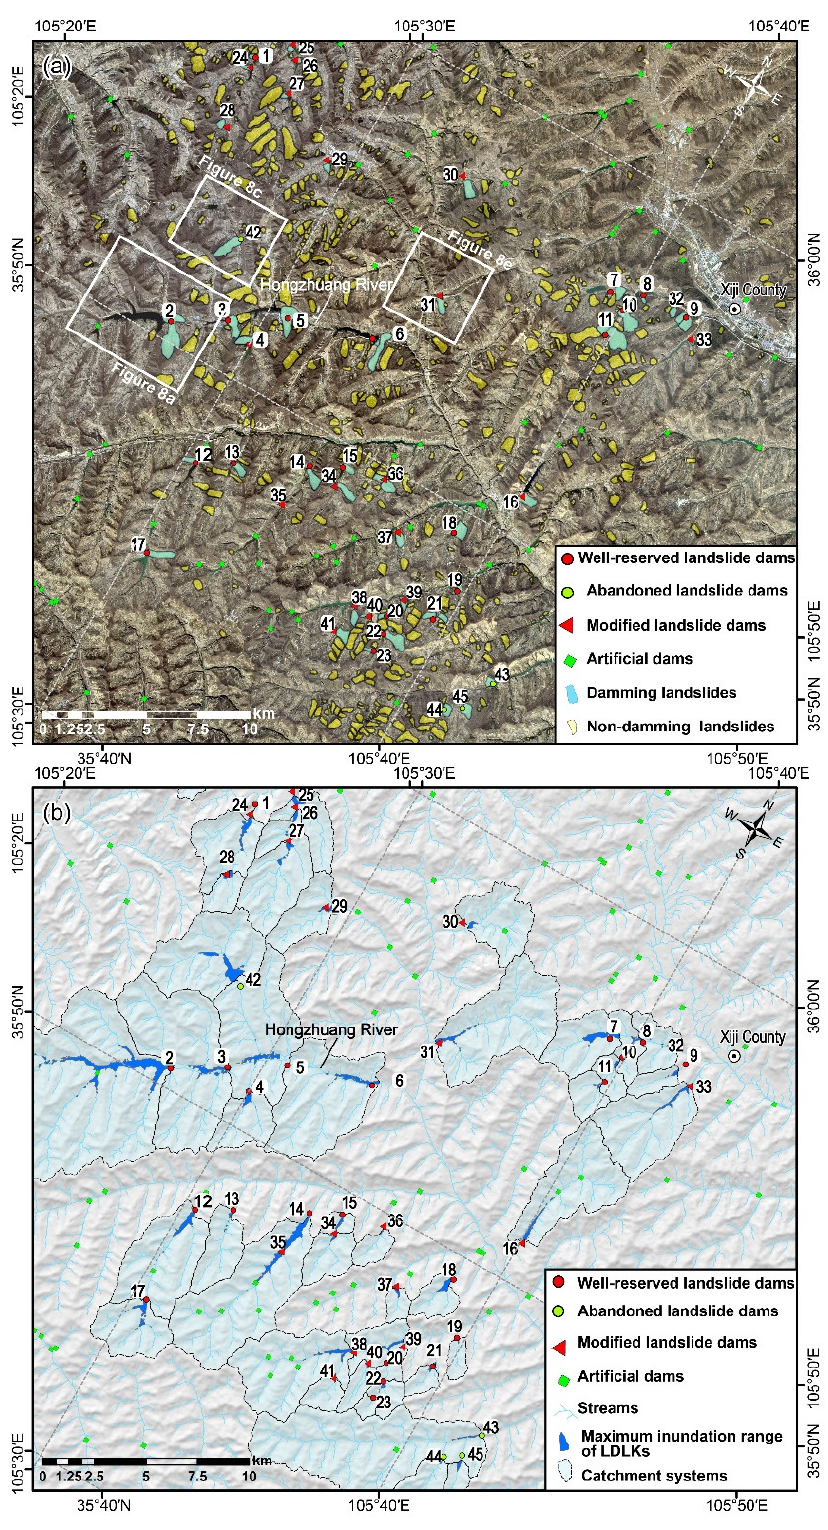
Figure 7. Distribution of landslides and landslide dams in western Xiji County [21]. ( a ) The back- ground is derived from GF-1 images. Damming landslides and non-damming landslides are shown in yellow and cyan, respectively. ( b ) The background is derived from hillshade images. The figure shows the stream network, watershed, and the inundation range of LDLKs.